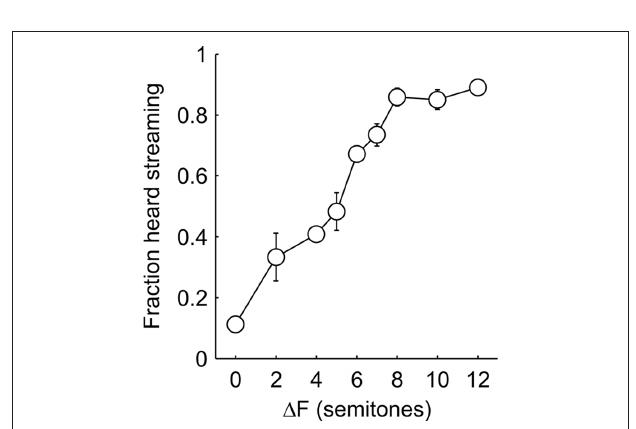
Figure 2 | intraoperative photographs, post-operative CT, and 3D registration of electrode coordinates on the cortical surface. (A,B) Intraoperative photographs showing the reflected dura, exposed pial surface, and overlaid electrode array (B) of an example subject who participated in the study. (C) Maximal-intensity projection of sagittally oriented CT scan showing all